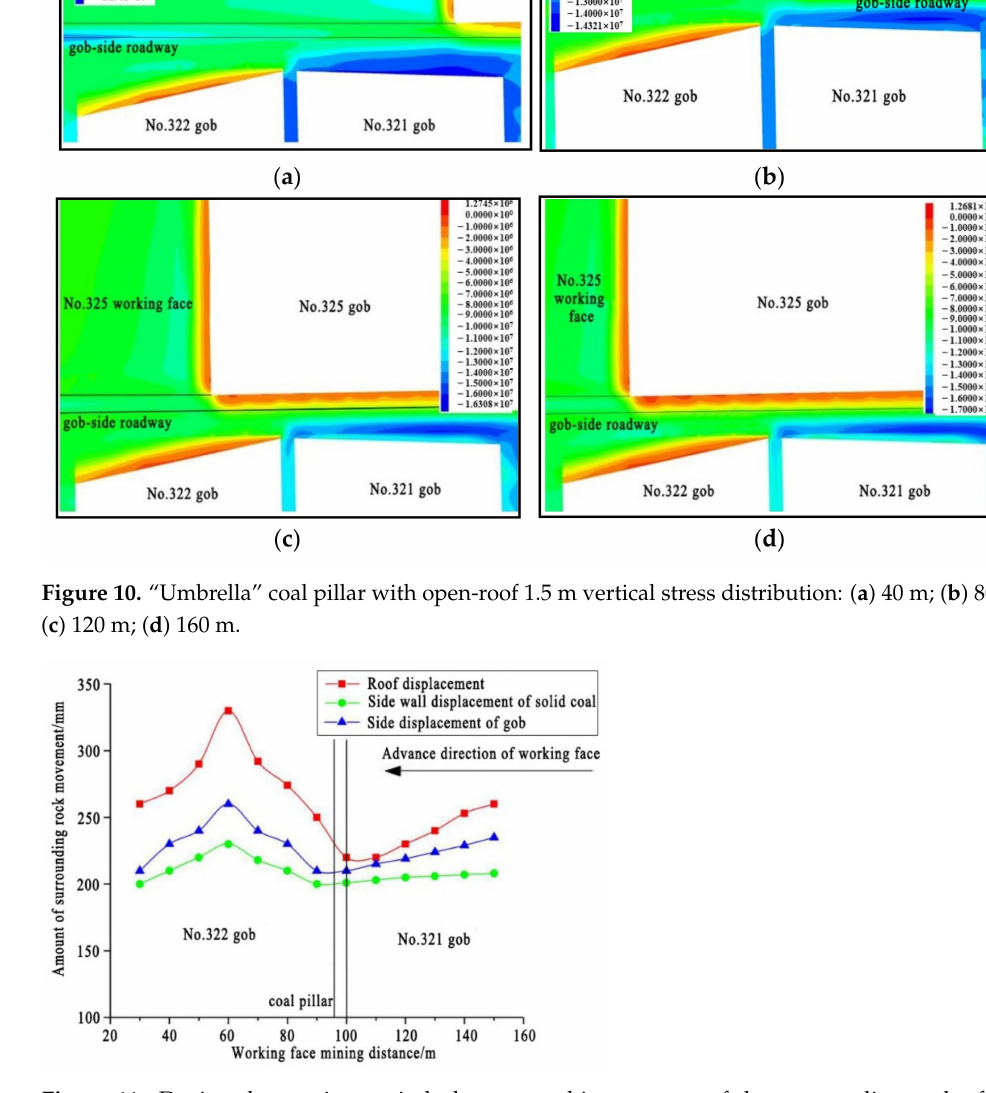
Figure 11. During the stoping period, the approaching amount of the surrounding rock of the roadway 20 m